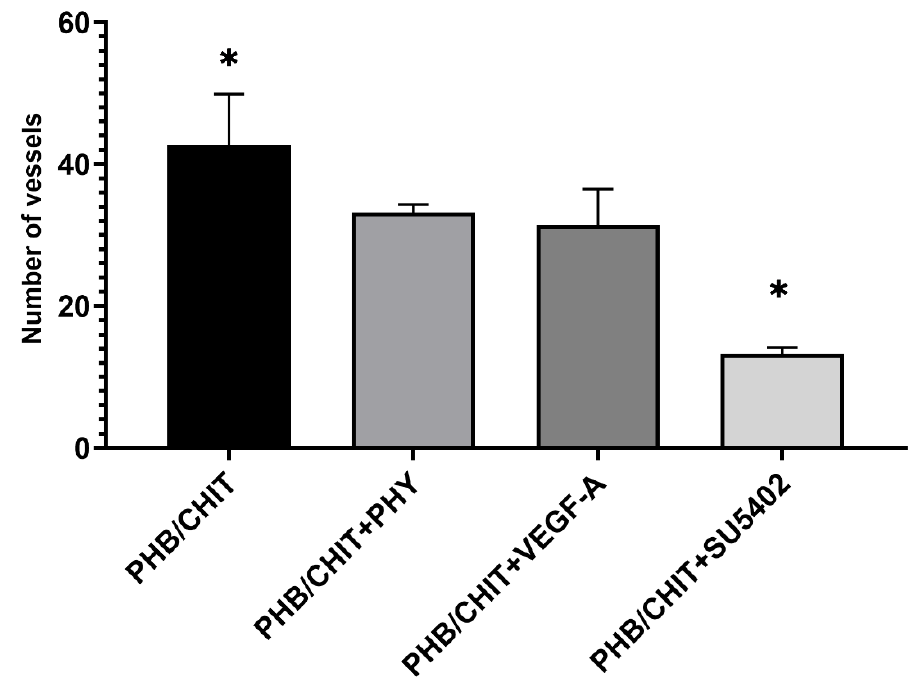
Figure 4. Number of the vessels in the surrounding area of the PHB/CHIT scaffold depending on the treatment of the material. The untreated porous scaffold showed the strong endogenous angiogenic potential while the treatment of the scaffold in the VEGFR-2/FGFR-2/PDGFR- β inhibitor (SU5402) led to a significantly lower number of the vessels around the PHB/CHIT. Experiments were repeated three times, and data are shown as mean ± SD (biological replicates: 6 samples for each group, technical replicates: 120 for each group). * p < 0.0001.